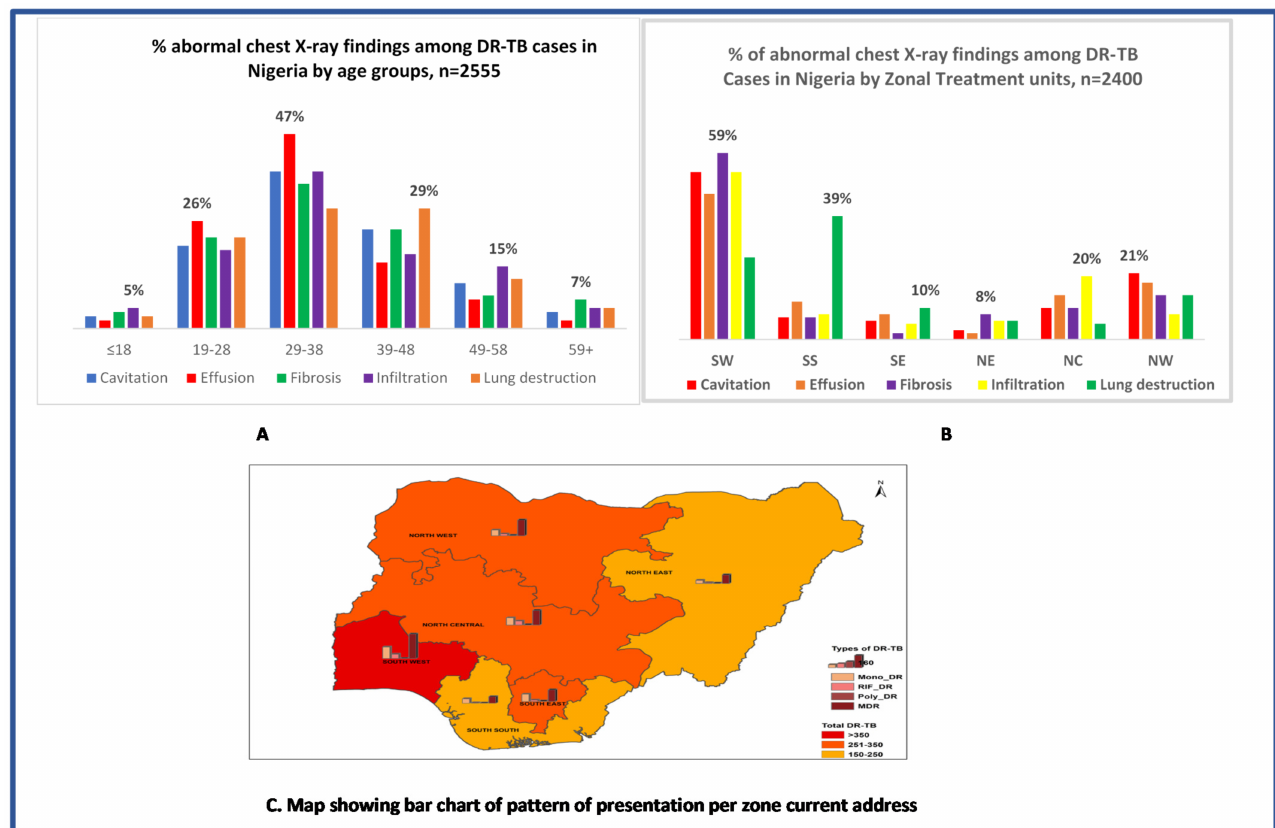
Figure 2. Distribution of DR-TB and pattern of abnormal CXR findings at presentation among DR-TB cases in